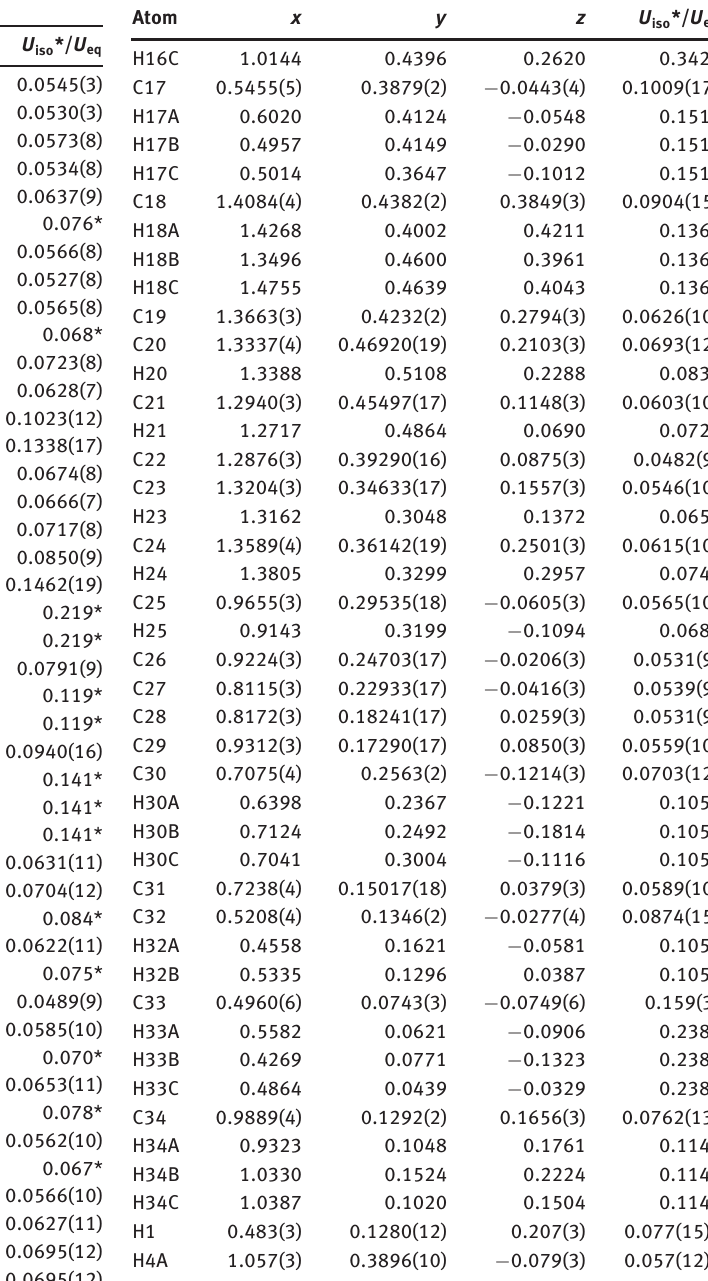
Table 2: Fractional atomic coordinates and isotropic or equivalent isotropic displacement parameters (Å 2